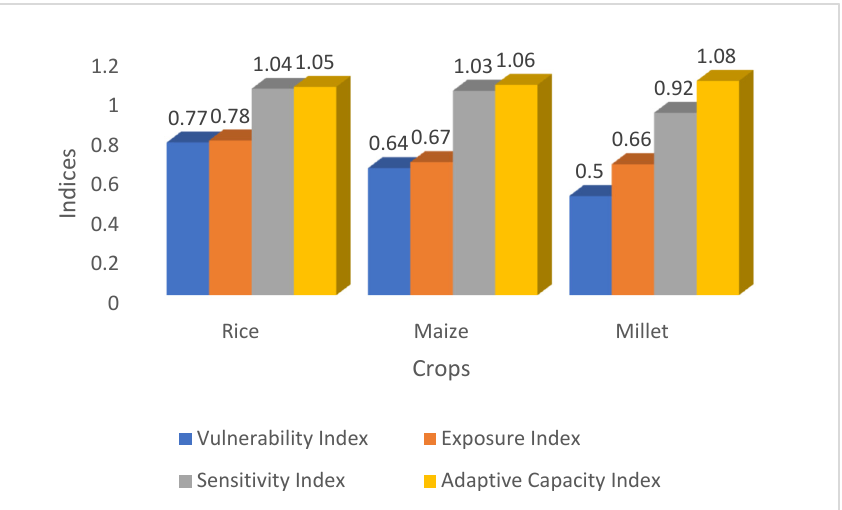
Figure 6. Simulated National Scale Exposure, Sensitivity, and Adaptive Capacity Indices.